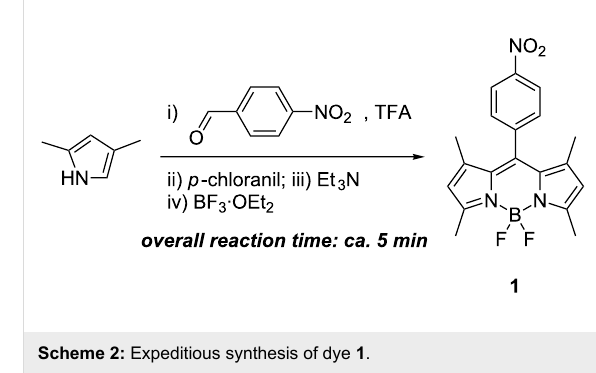
Scheme 2: Expeditious synthesis of dye 1 .